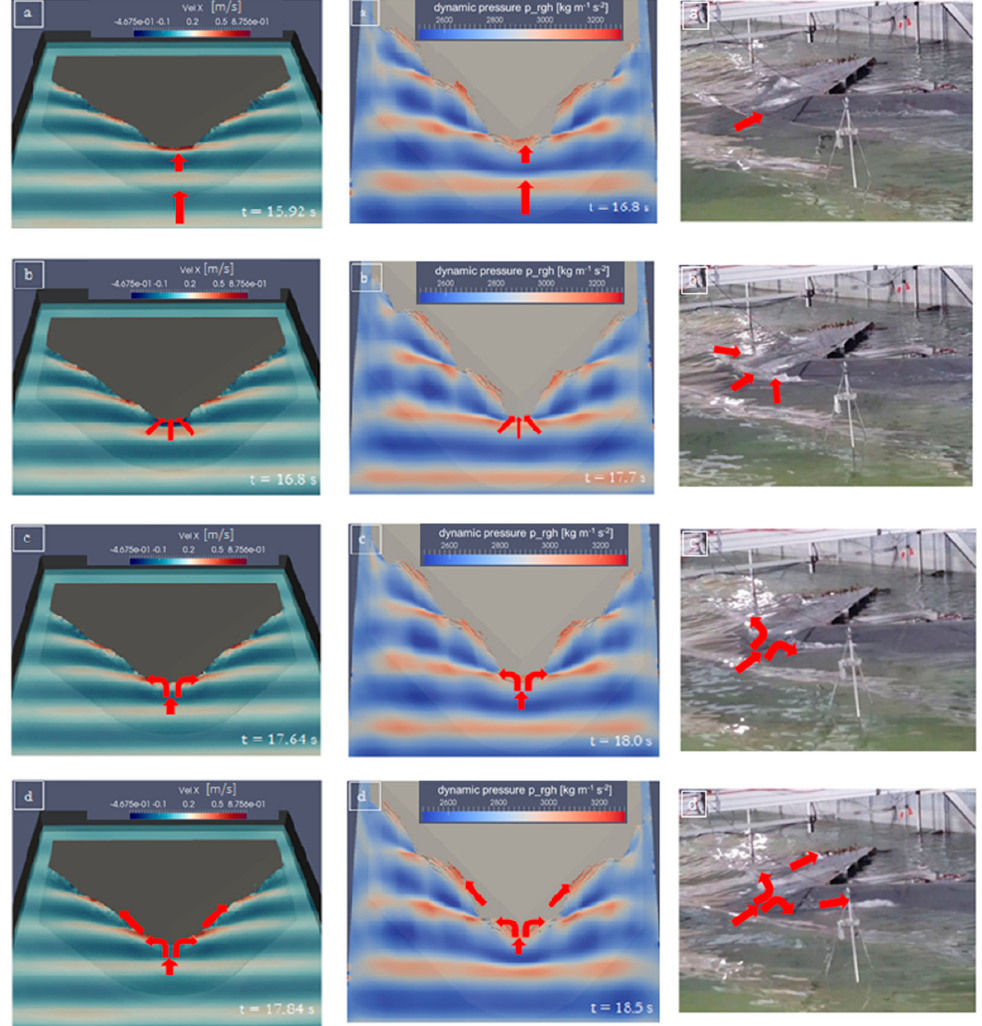
Figure 6. Wave transformation processes on a 270° convexly curved dike (Left: DualSPHysics, Middle: OpenFOAM, Right: Physical model); H = 0.10 m, T = 1.46 s, β = 0 ◦ OpenFOAM, Right: Physical model); H = 0.10 m, T = 1.46 s, β = 0°.